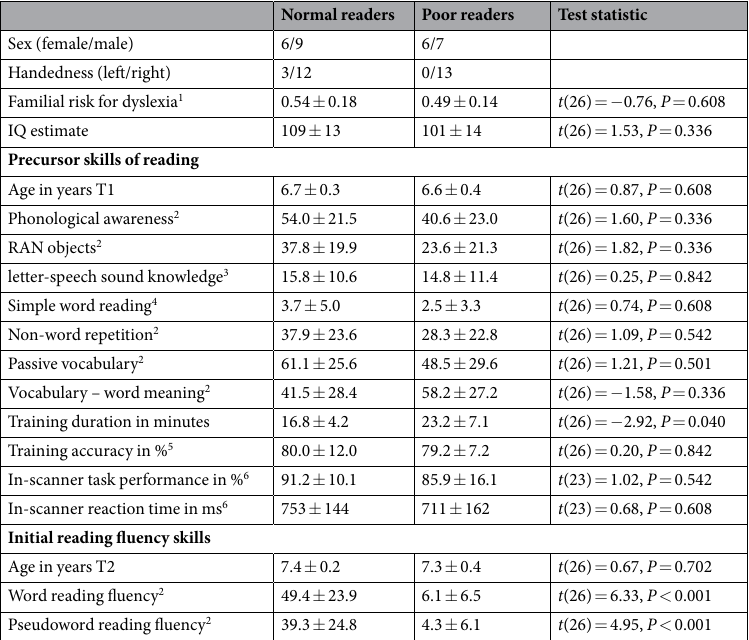
Table 1. Group statistics ( n = 28). Values are mean ± standard deviation, P -values are FDR-adjusted. 1 Highest parental ARHQ score; 2 percentile scores; 3 raw values; 4 number of correctly read one- or two-syllable upper case letter words out of 20; 5 trial-wise item-weighted accuracy; 6 n = 25, three subjects from the poor reading group excluded (Methods); T1: prereading stage; T2: beginning reading stage.